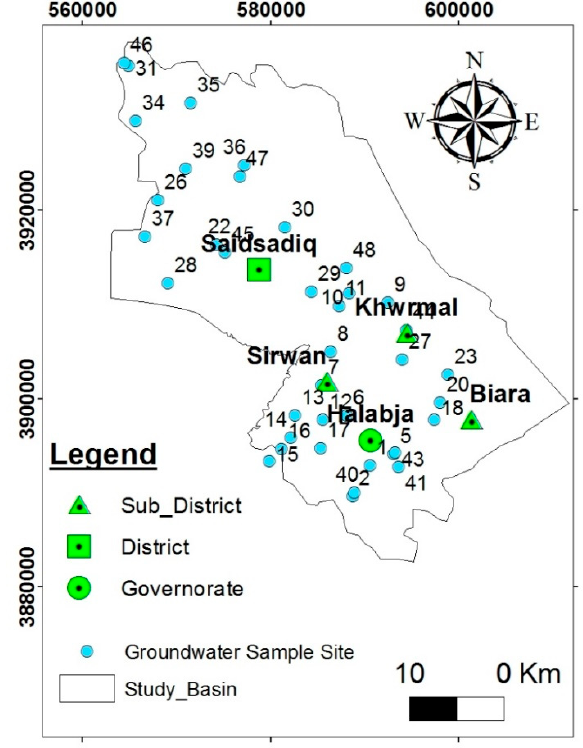
Figure 5. Site map of collected groundwater samples.